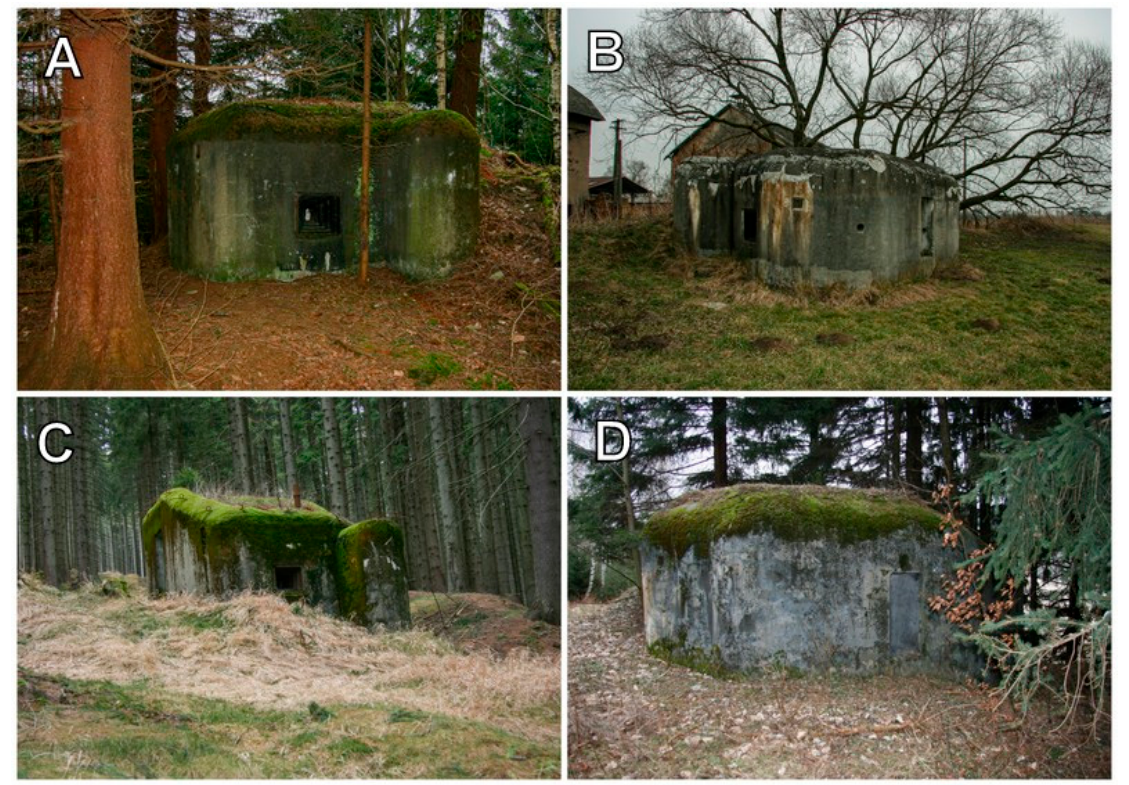
Figure A4. ( A ): Each A ‐ CEF object has unique genius loci (e.g., SA ‐ CEF number 38). ( B ): A ‐ CEFs represents a specific type of military brownfields (e.g., SA ‐ CEF number 17). ( C ): SA ‐ CEF number 38 is one of the existing and highest situated objects (715 m above sea level). It serves as an occasional refuge for adventurers and ‘could certainly tell’ many stories. ( D ): Some A ‐ CEFs can be easily mistaken for rock (e.g., SA ‐ CEF number 39).